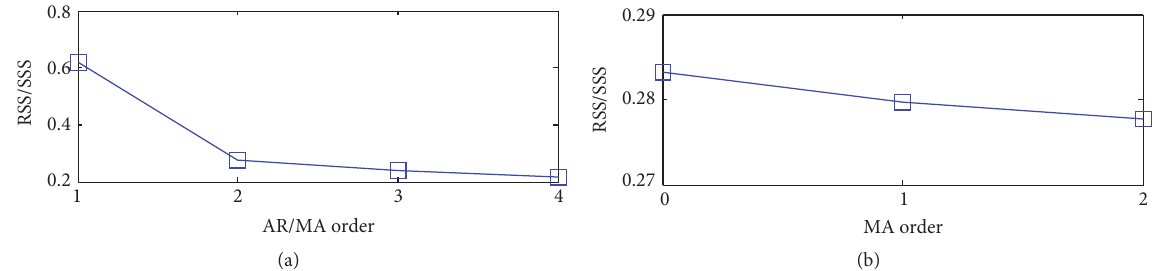
Figure 15: KRR-FS-TARMA model order selection: (a) AR order and (b) MA order.